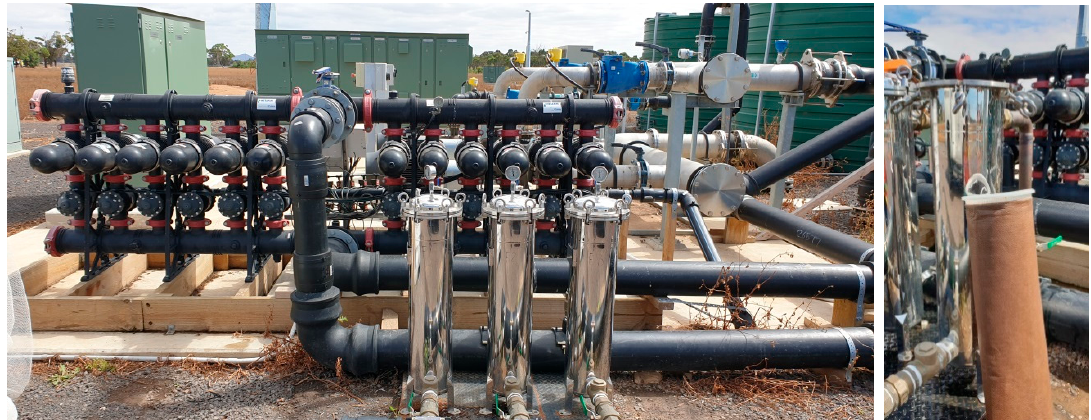
Figure 8 . ( Left ): Central manifold ASR System with temporary prefiltration unit that includes a 20 μ m spin Klin disc (the 12 black cylinders) followed by a 1 μ m bag filter (the 3 upright cylinders). ( Right ): clogging of the 1 μ m bag filter after ~2 days of operation.